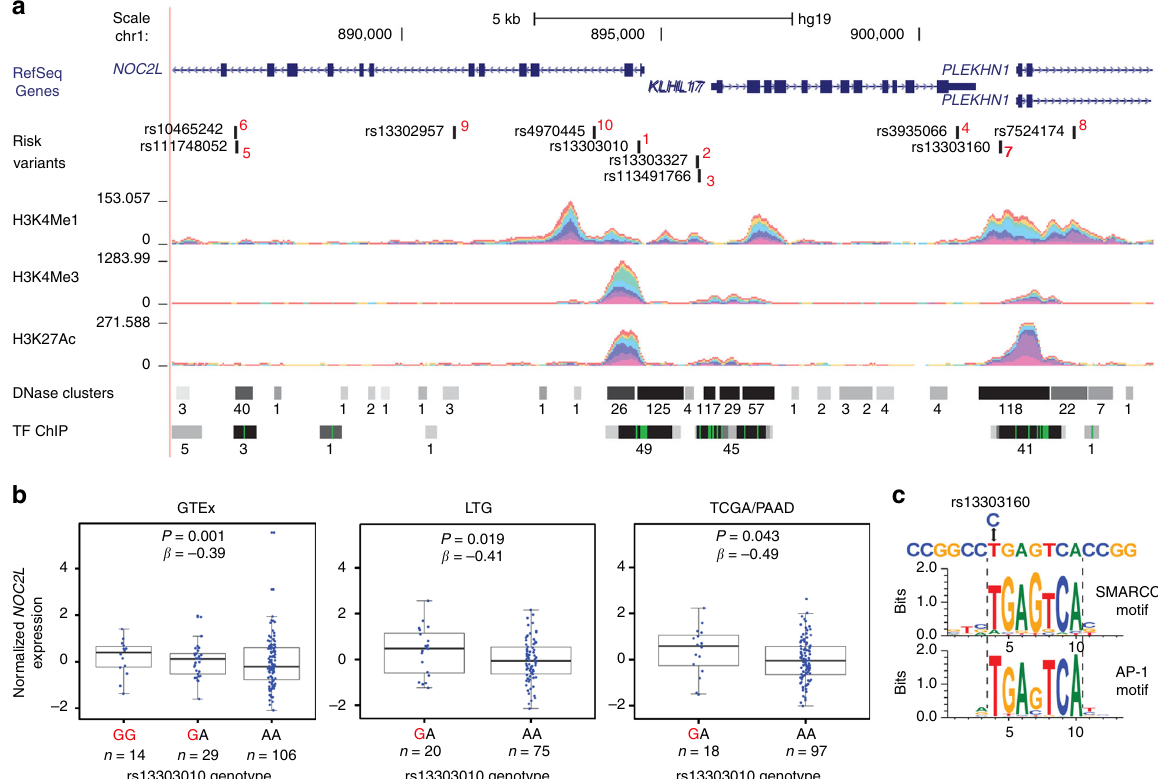
Fig. 2 Functional analysis of the 1p36.33 risk locus. a The set of most likely functional variants at 1p36.33 and their P value rank (1 – 10, in red) is shown as well as overlapping RefSeq genes on chr1: 885,555-904,522 (NCBI GRCh37/Hg19). ENCODE data for histone modi fi cation marks (H3K4me1, H3K4me3, H3K27Ac) are indicated by colored density plots. Open chromatin (DNase hypersensitivity regions, DNase clusters) and binding of transcription factors (TF ChIP) are indicated by horizontal bars. The numbers next to each bar indicate the number of cell lines with DNase clusters, or the number of different transcription factors bound across all tested cell lines. The panel is adapted from the UCSC Genome Browser. b Expression QTLs in histologically normal autopsy-derived pancreatic tissues ( n = 149) from the GTEx consortium (GTEx), the Laboratory of Translational Genomics histologically normal adjacent- to-tumor pancreatic tissue set (LTG, n = 95), and the TCGA pancreatic cancer tissue set (TCGA/PAAD, n = 115). Normalized NOC2L expression is shown on the y axis and genotypes at the marker SNP at 1p36.33 on the x axis. Risk-increasing alleles are marked in red. Note that no samples in the LTG and TCGA/PAAD sets were of the minor homozygous risk genotype (GG). The box-and-whisker plots show the median (horizontal middle line within each box), interquartile range (top and bottom horizontal lines of each box), and 1.5 times the IQR (whiskers). c Analysis of the effects of 1p36.33 variants on transcription factor motifs for rs13303160 ( r 2 = 0.93 with rs13303010 in 1000G EUR). The risk allele (C) at this marker alters predicted